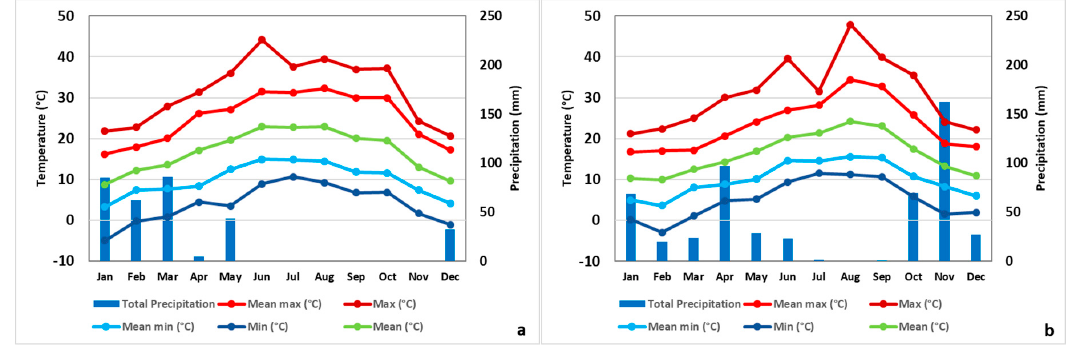
Figure 3. Accumulated reference (ET o ), actual evapotranspiration (ET c adj ), transpiration (T) and soil